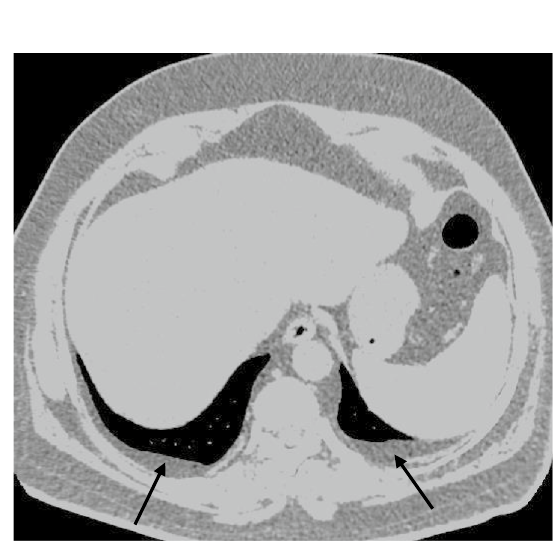
Fig. 1 50‑year‑old male patient with known history of chronic corticosteroids administration presented with shortness of breath and chest tightness. Axial CT mediastinal window image showing bilateral rather symmetrical fatty expansion of the EPS